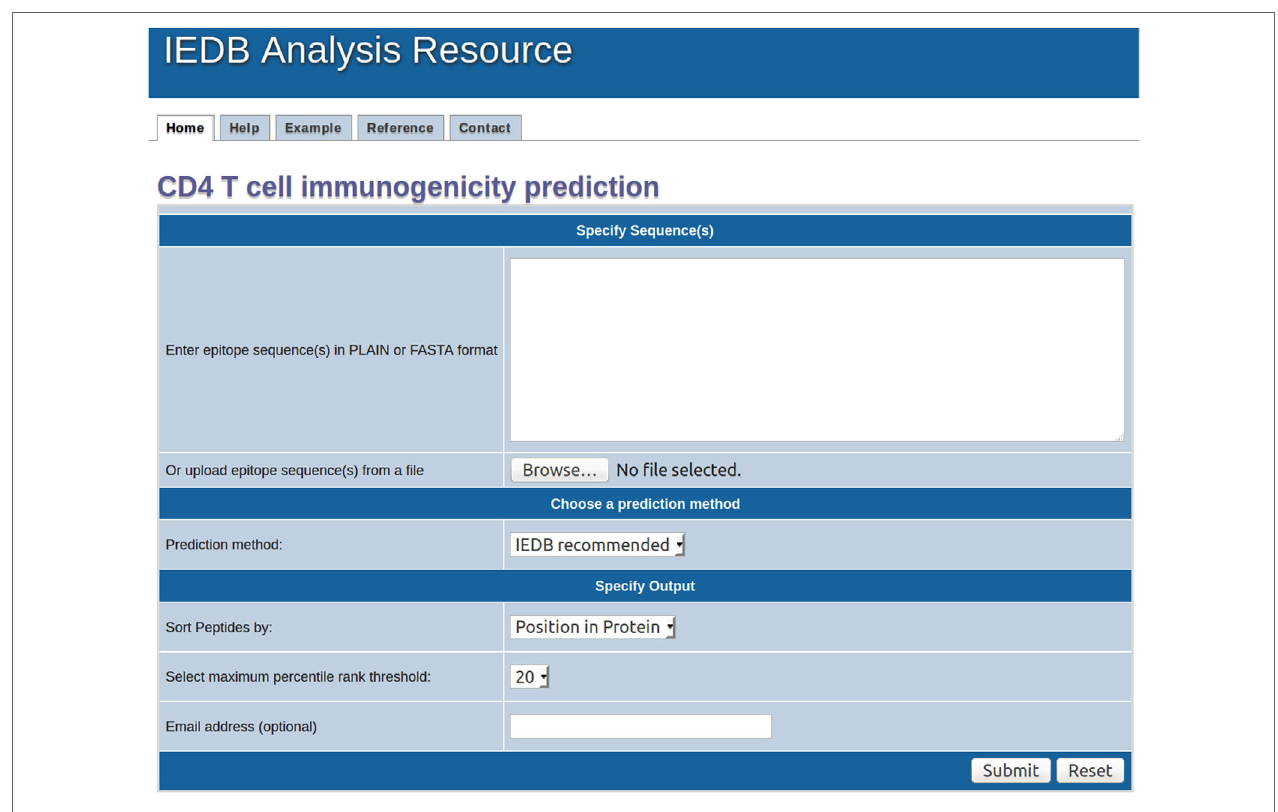
FigUre 5 | Screenshot for home page of immunogenicity prediction